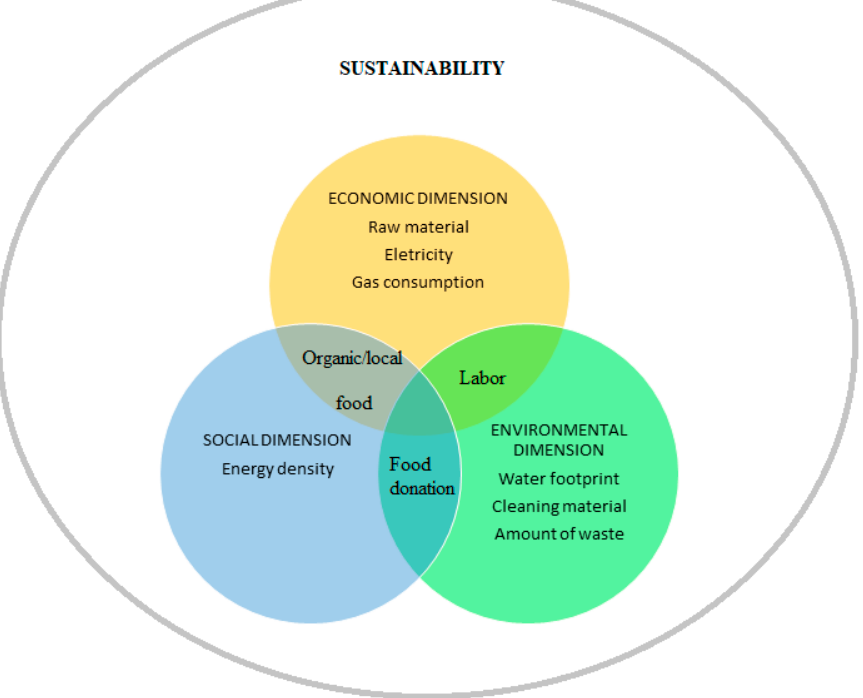
Figure 1. Impacts of food waste in foodservice.